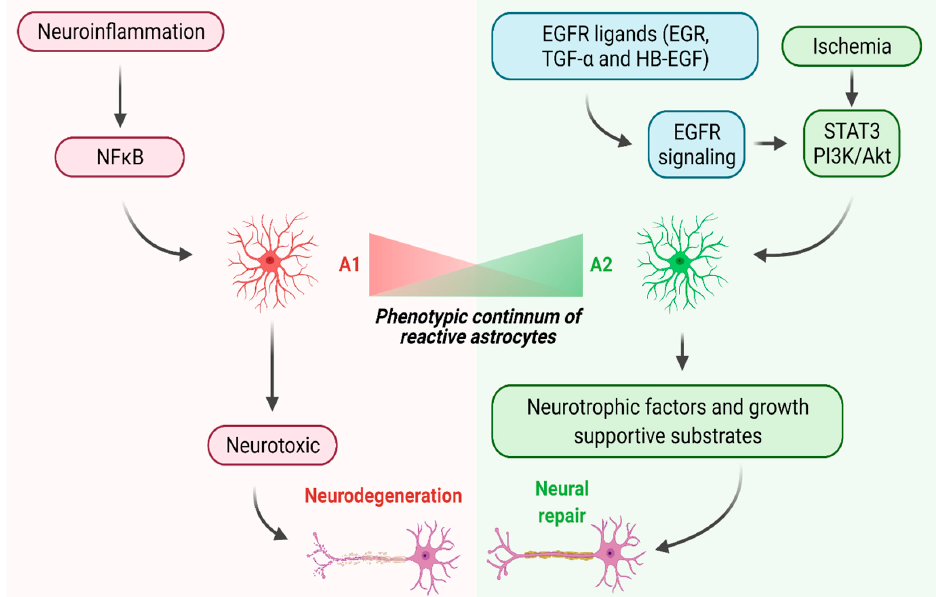
Figure 1. Neuroinflammation and ischemia lead to the generation of A1 and A2 astrocytes, respectively, in the spinal cord. Neuroinflammation may activate the NF κ B pathway in reactive astrocytes and induce the A1 phenotype; on the other hand, ischemia may activate the STAT3 and/or PI3K/Akt pathways and induce the A2 phenotype. A1 and A2 astrocytes may exist on a phenotypic continuum. A1 astrocytes may be neurotoxic and promote neurodegeneration whereas A2 astrocytes may release neurotrophic factors and growth-supportive substrates and promote both survival and axon regeneration of CNS neurons. EGFR ligands may induce the generation of A2 astrocytes via activation of STAT3 and PI3K/Akt pathways (created with BioRender.com). Abbreviations: EGF, epidermal growth factor, EGFR, epidermal growth factor receptor, TGF- α , transforming growth factor- α , HB-EGF, heparin-binding EGF-like growth factor, NF κ B, nuclear factor κ B, STAT3, signal transducer and activator of transcription 3, PI3K/Akt, phosphoinositide 3-kinase/protein kinase